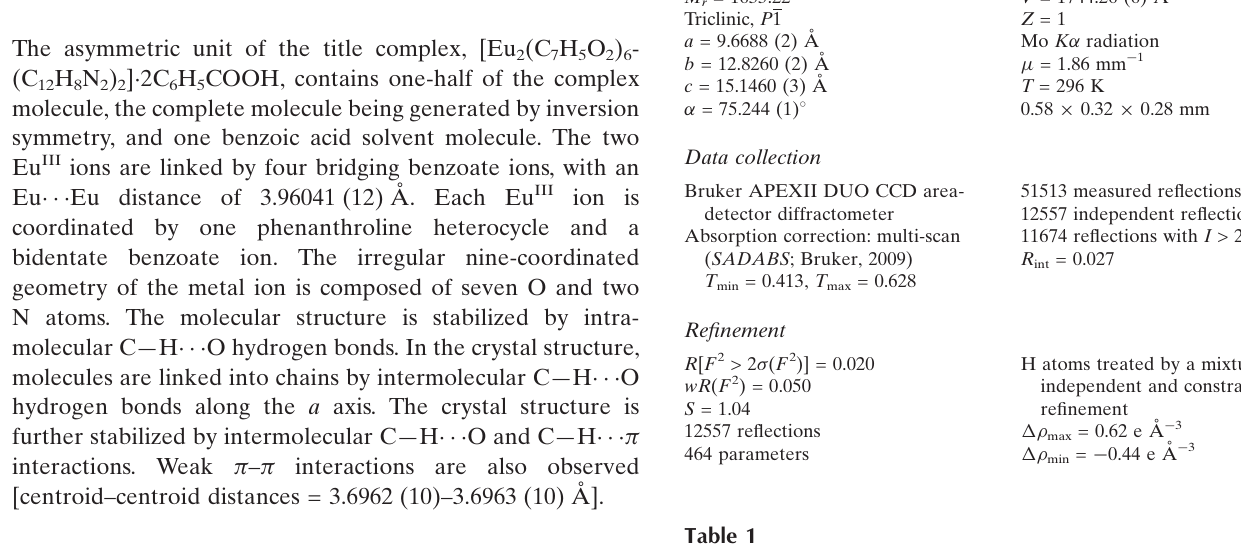
Selected bond lengths (A˚